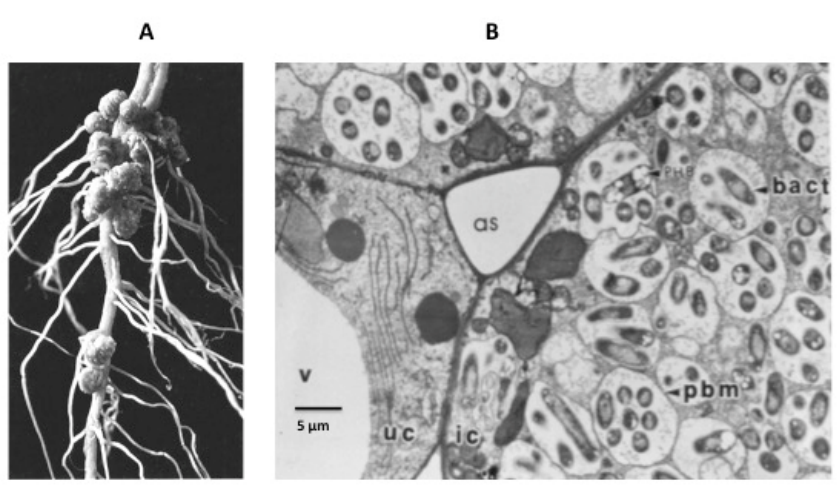
Figure 1. ( A ) nodules on the root of a soybean plant. ( B ) detail of infected cells. V = vacuole; as = air space; uc = uninfected cell; ic = infected cell; pbm = peribacteroid membrane, now known as the symbiosome membrane; bact = bacteroid.